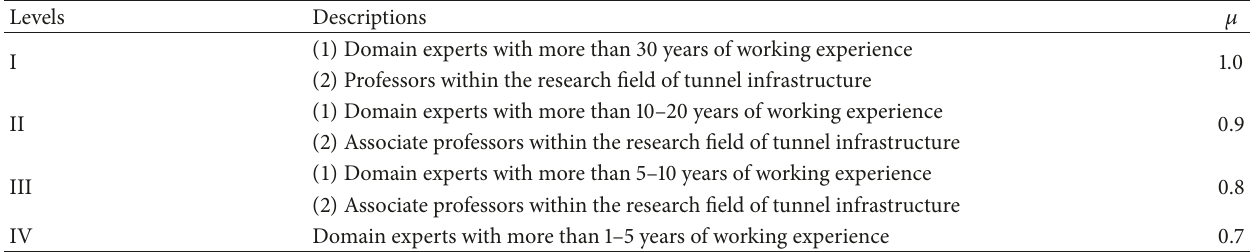
Table 3: Setting of experts’ judgment ability levels (Source from: